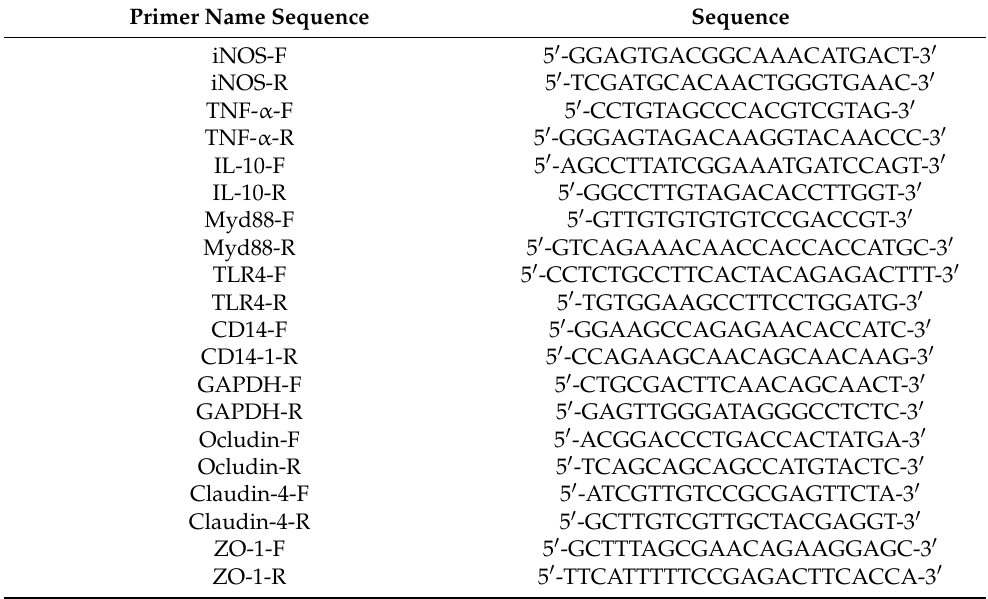
Table 1. RT-qPCR primer